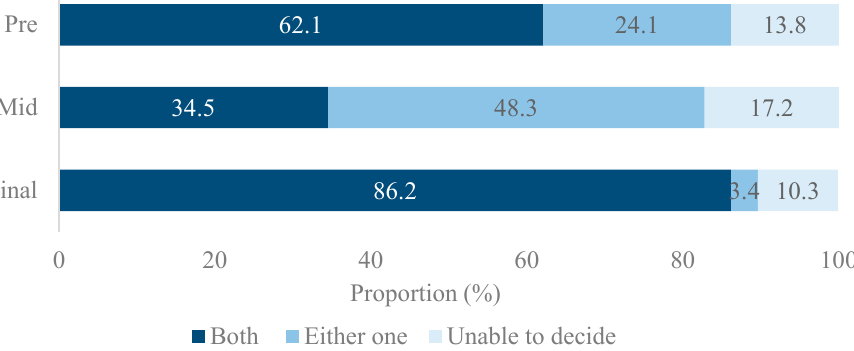
Figure 3. The proportion of agreement to double- coverage for partial denture and implant services on the same jaw in pre-, mid-, and final survey .